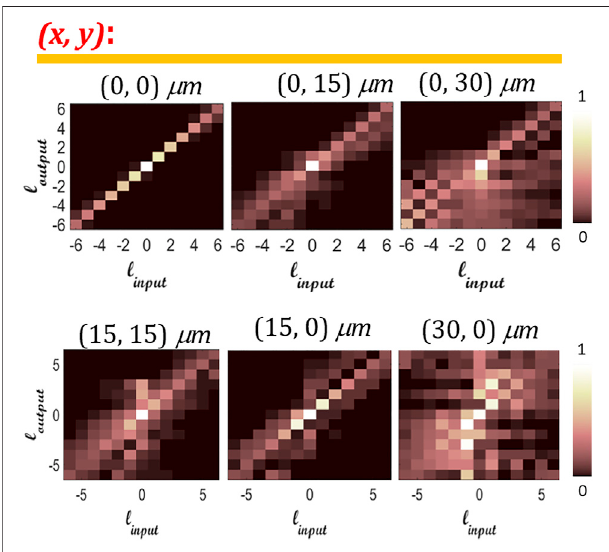
FIGURE9| Calculatedcross-talkmatrixfor13modes, forvariouscases of system displacements (15, 30 μ m).